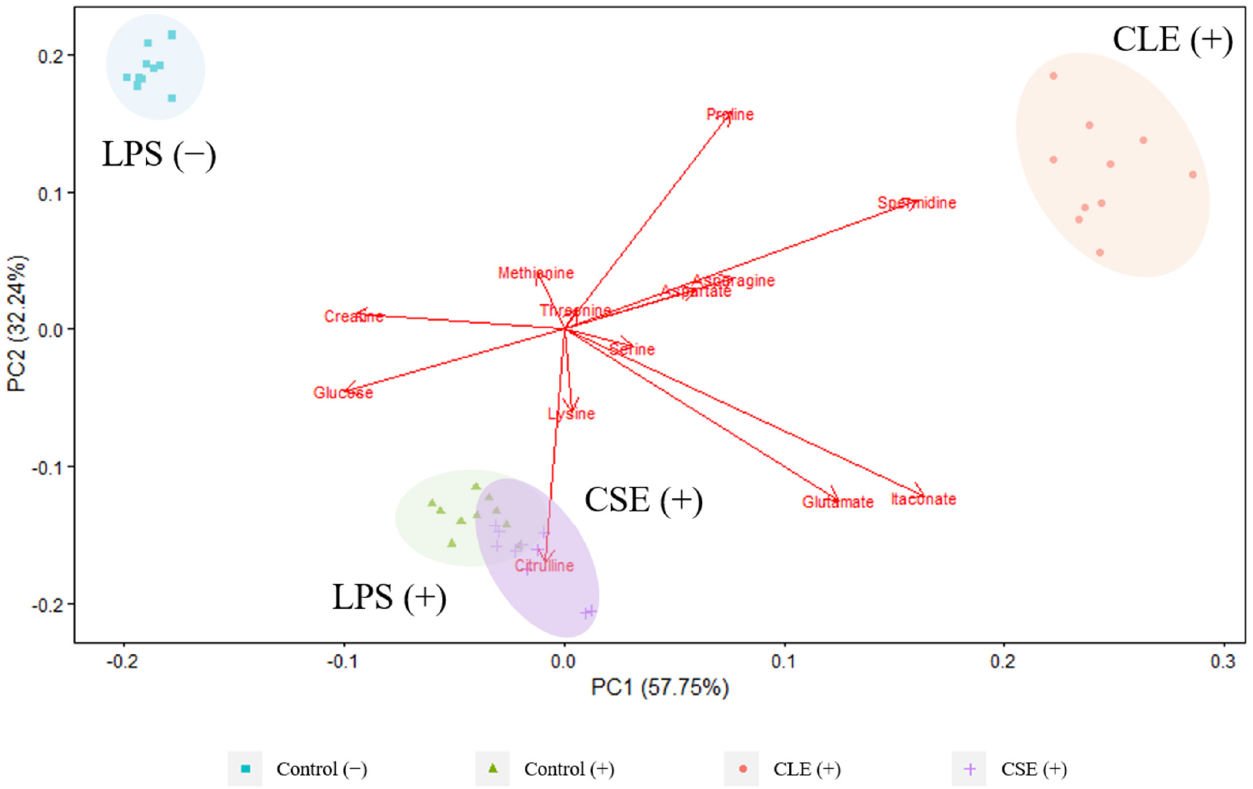
Figure 3. PCA biplot derived from LC-MS-targeted analysis of culture medium from different treatment groups. (+) and ( − ) refer to LPS-stimulated and unstimulated cells, respectively. Red arrows represent metabolite loading vectors, and their distance from the origin indicates the extent of their influence on the PCs.